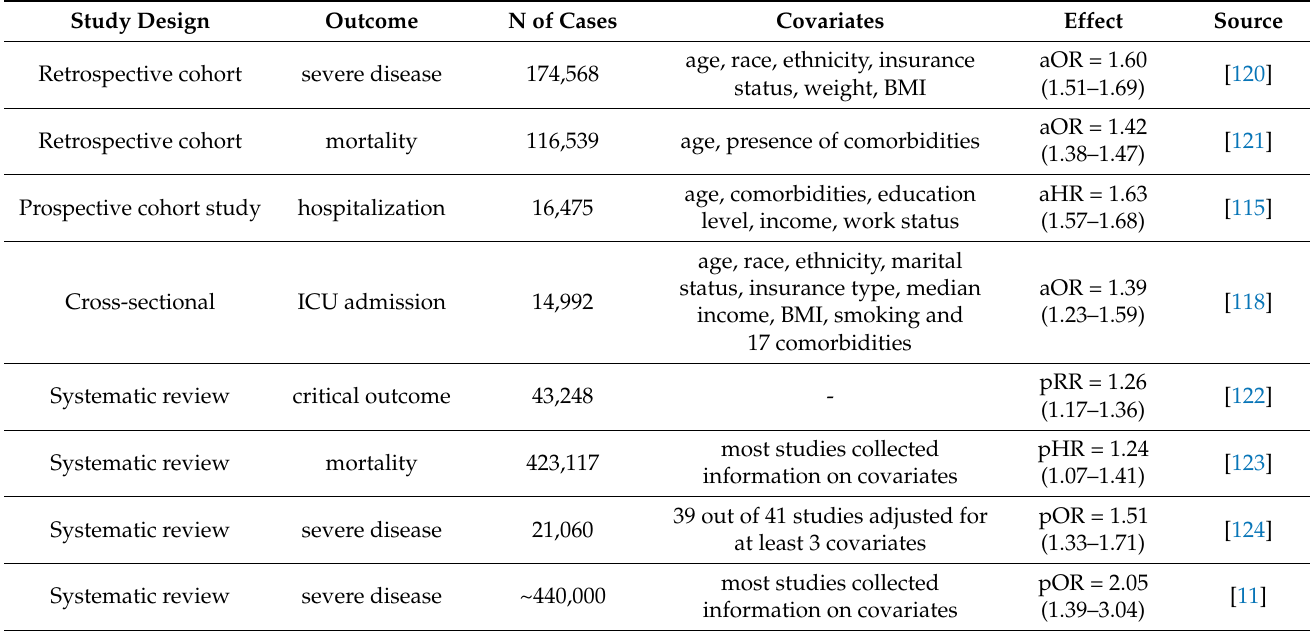
Table 2. Large clinical studies and systematic reviews demonstrating the association of male sex with increased COVID-19